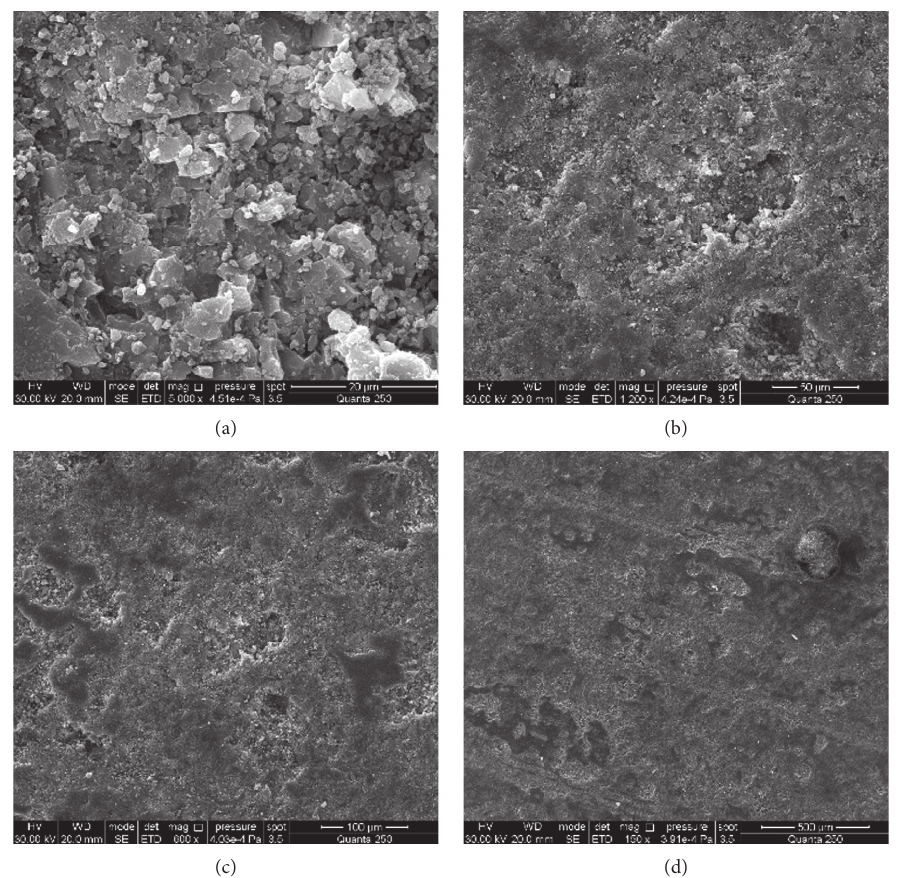
Figure 9: Scanning electron microscope pictures with different multiples.